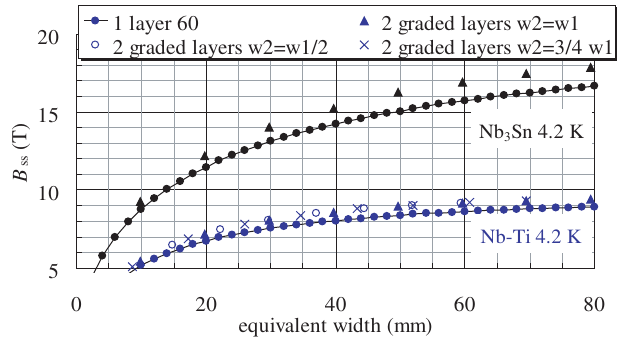
FIG. 10. Optimal grading, providing the highest short sample field, as a function of the sector width, (cid:5) (cid:1) 0 : 35 , Nb-Ti.